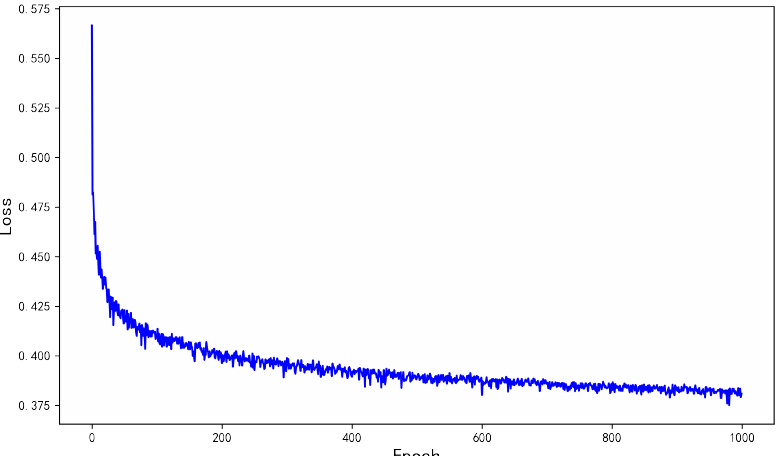
Figure 6. Training process for QSAR dataset when learning the rate is